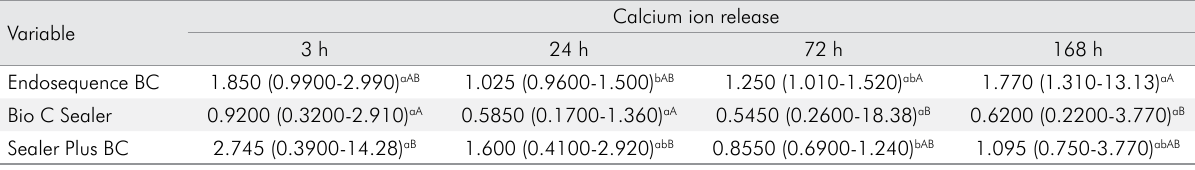
Table 4. Median, minimum and maximum calcium values (mg/L) released form the studied materials in the different experiment period.